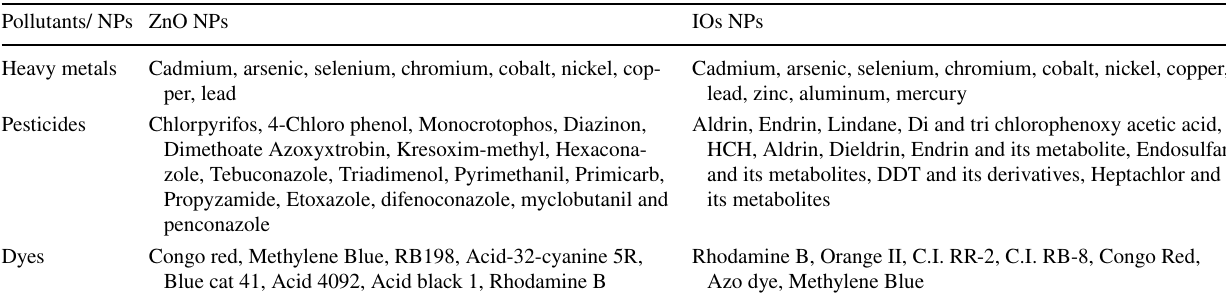
Table 4 Comparison of ZnO and IOs NPs as a decontaminating agent Pollutants/ NPs ZnO